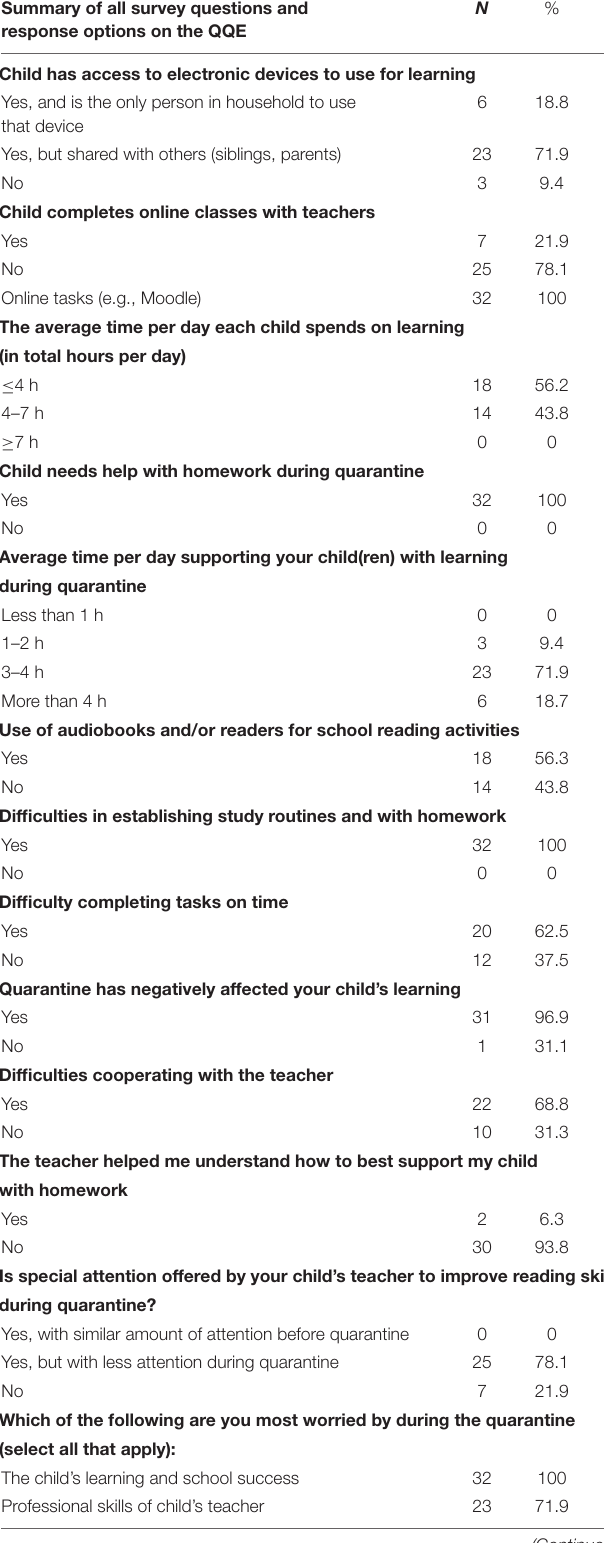
TABLE 6 | Educational conditions and potential challenges reported by parents during Spain’s National Quarantine. Summary of all survey questions and response options on the